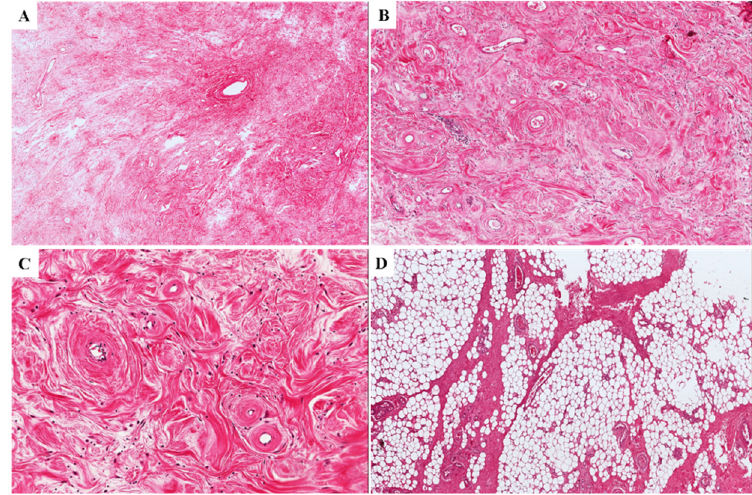
Figure 10. Primary DAM with fibro-sclerotic stroma . Low ( A ) and higher magnifications ( B , C ) illustrating a predominantly hypocellular and fibro-sclerotic stroma; thick keloid-like collagen bands ( B ) and blood vessels with perivascular hyalinization ( C ) are also observed; ( D ) this tumor shows a fibro-lipomatous appearance at the margins: Adipose tissue is diffusely infiltrated by fibrous septa.